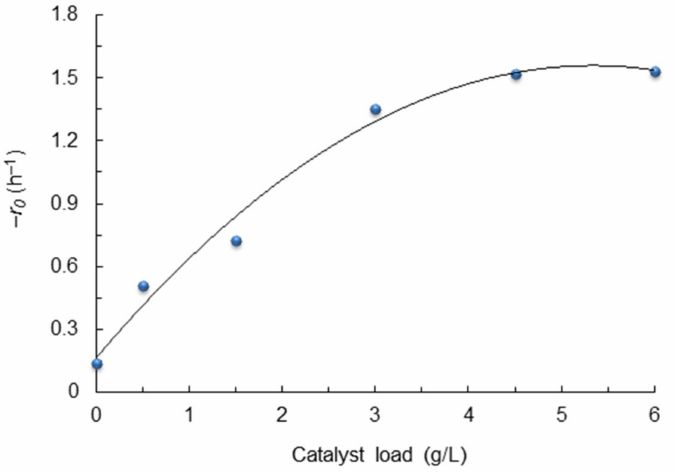
Figure 10. Initial rate of Reactive Violet 5 (RV5) removal as a function of catalyst load (c 0 RV5 = 30 ppm; pH =